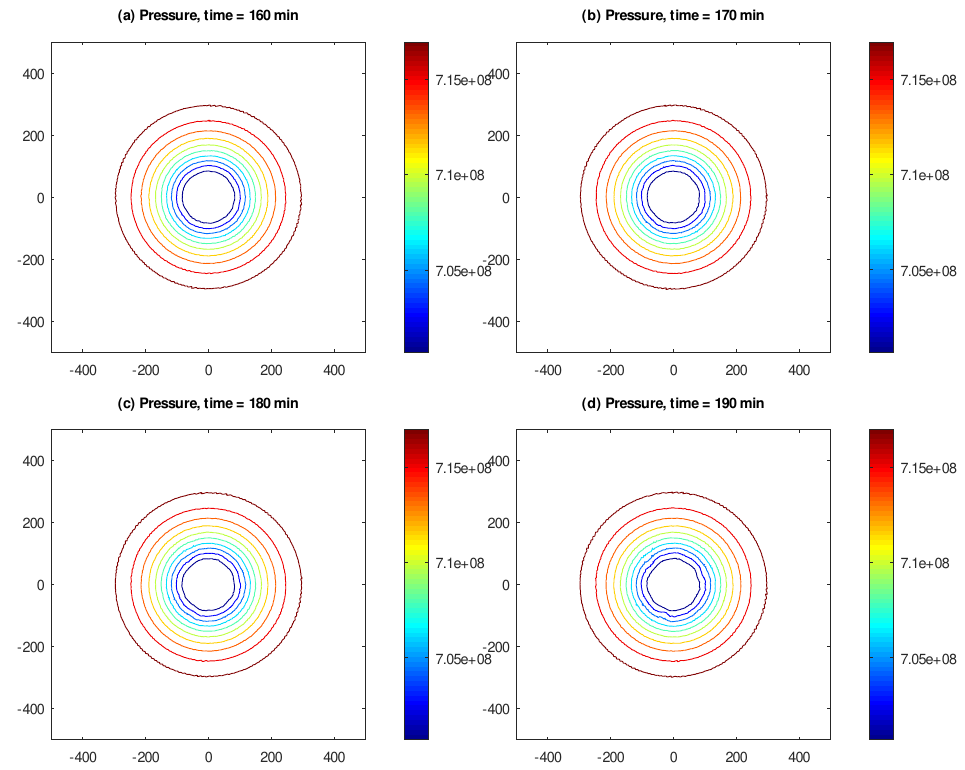
Figure 8. Pressure of the cyclostrophic flow, expressed in kg/s 2 , and captured at ( a ) 160, ( b ) 170, ( c ) 180 and ( d ) 190 min of elapsed model time. The domain size is 1000 × 1000